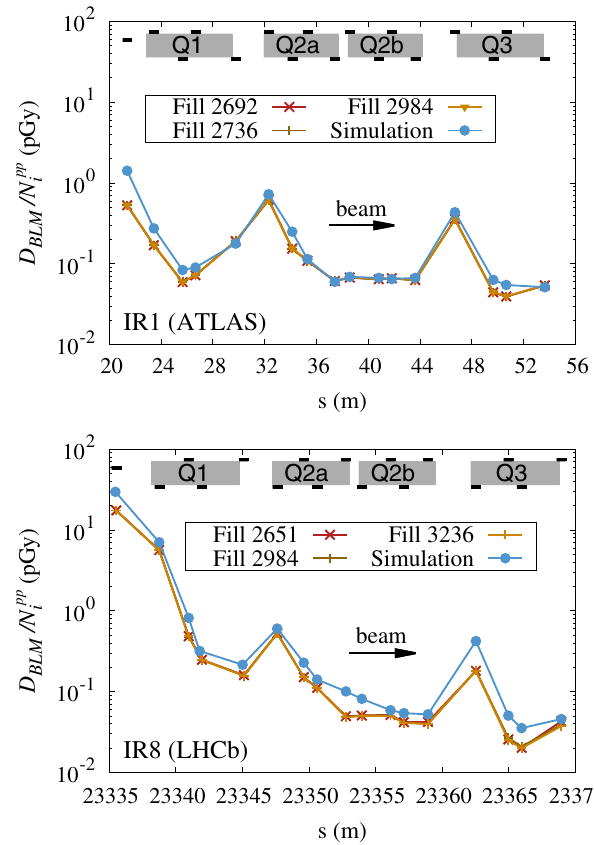
FIG. 16. Simulated and measured BLM signals along final focus quadrupoles for proton-proton collisions at a center-of- ffiffiffi p s ¼ 8 TeV in ATLAS (top) and LHCb mass energy of (bottom). The measurements were recorded during different physics fills in 2012. All signals are per proton-proton collision in the respective interaction point. The statistical error of the simulation results is smaller than